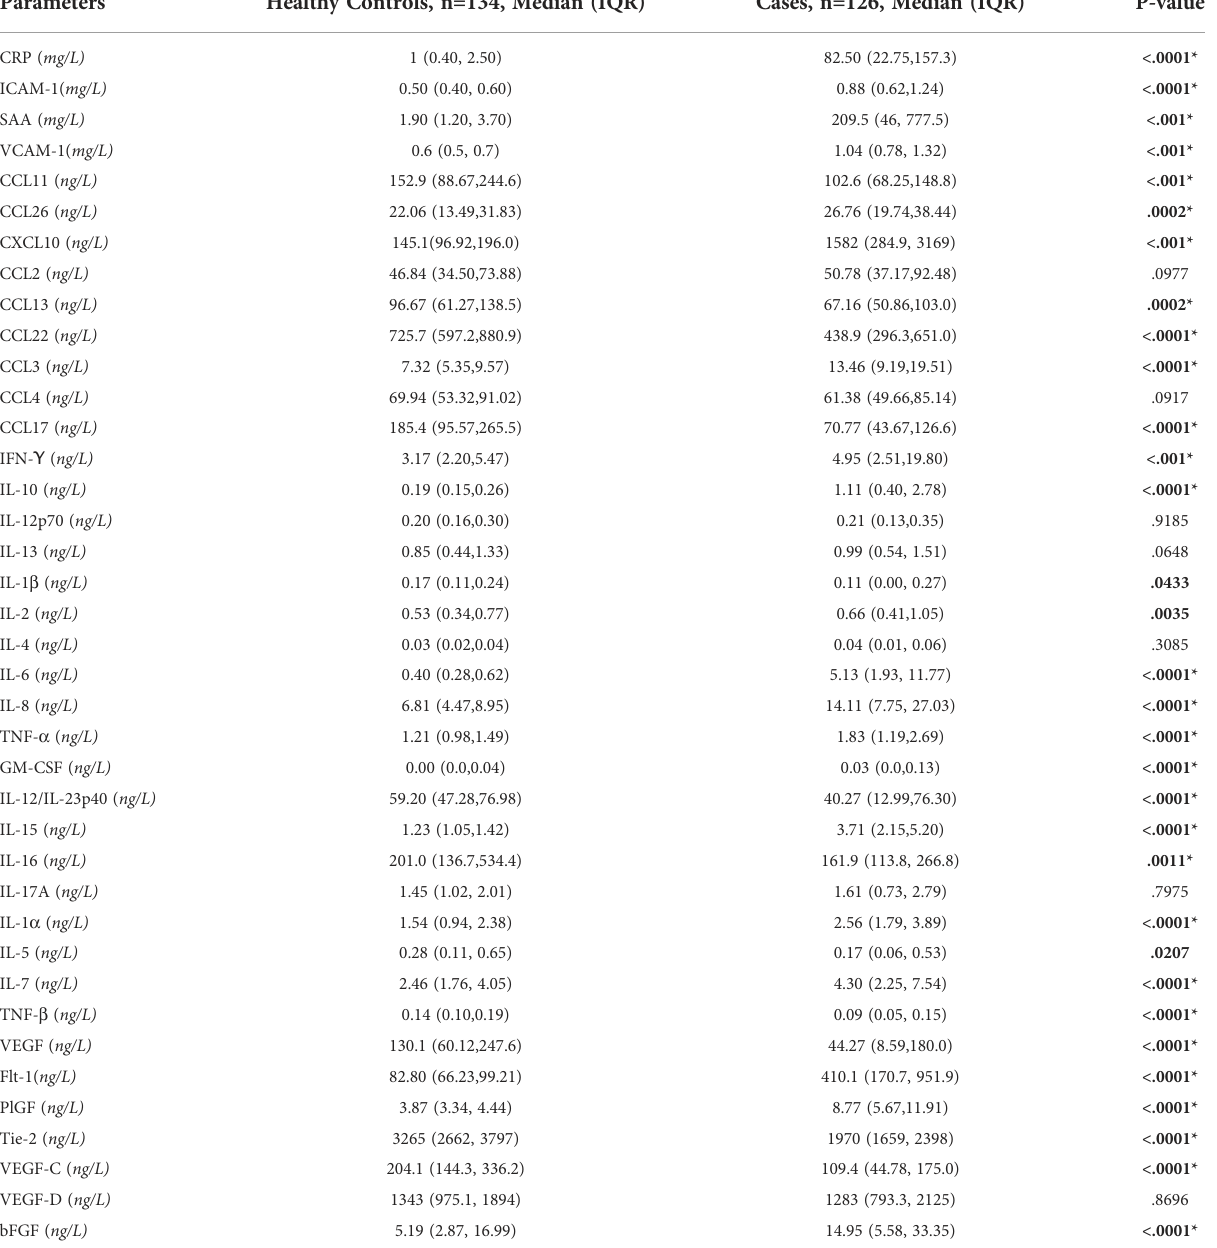
TABLE 3 Concentration of in fl ammatory biomarkers sorted as healthy controls and COVID-19 patients. Parameters Healthy Controls, n=134, Median (IQR) Cases, n=126, Median (IQR)